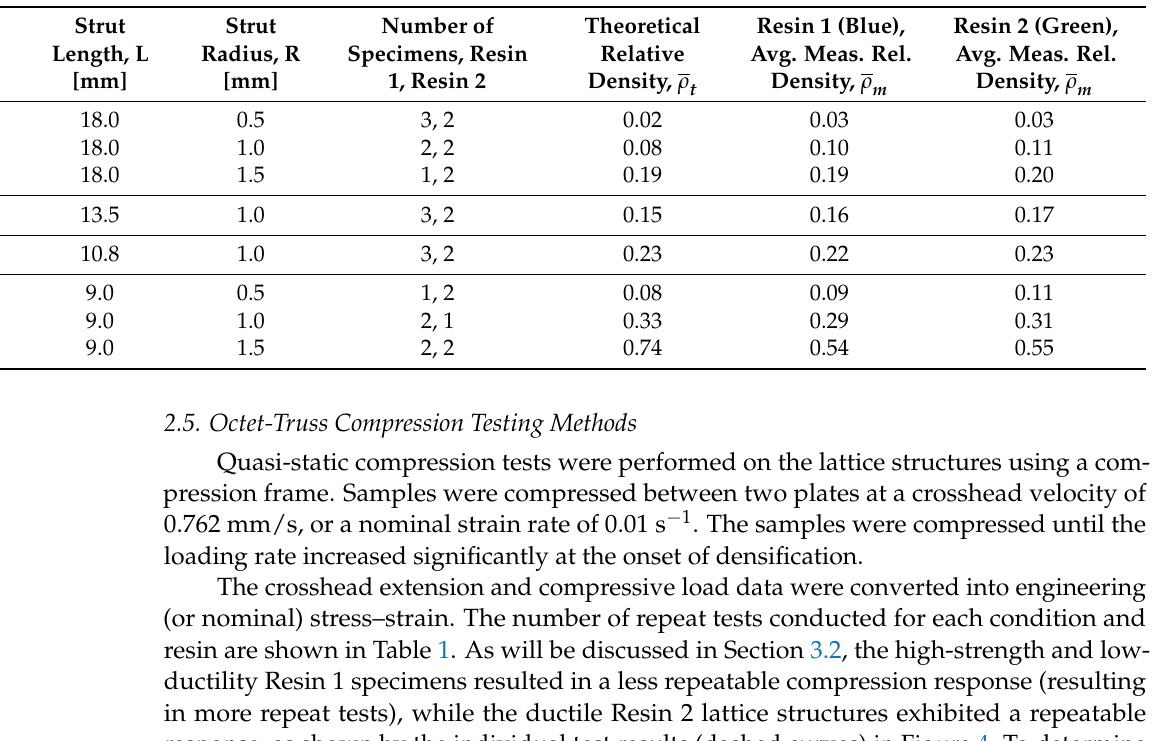
Figure 3. ( a ) Octet-truss unit cell showing the three different strut radii; ( b ) octet-truss lattices in all four cell sizes with a 1.0 mm strut radius. four cell sizes with a 1.0 mm strut radius. Table 1. Summary of the lattice structure geometry and relative density. Table 1. Summary of the lattice structure geometry and relative